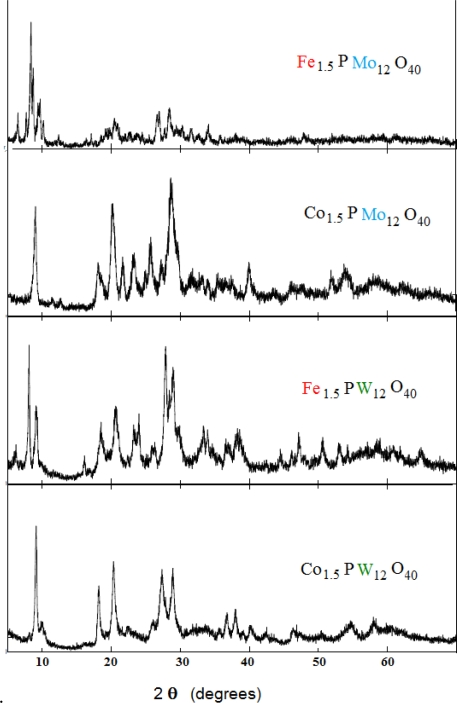
X-ray powder diffraction (XRD) patterns of PW12O40 and PMo12O40 having cobalt and iron as countercations.